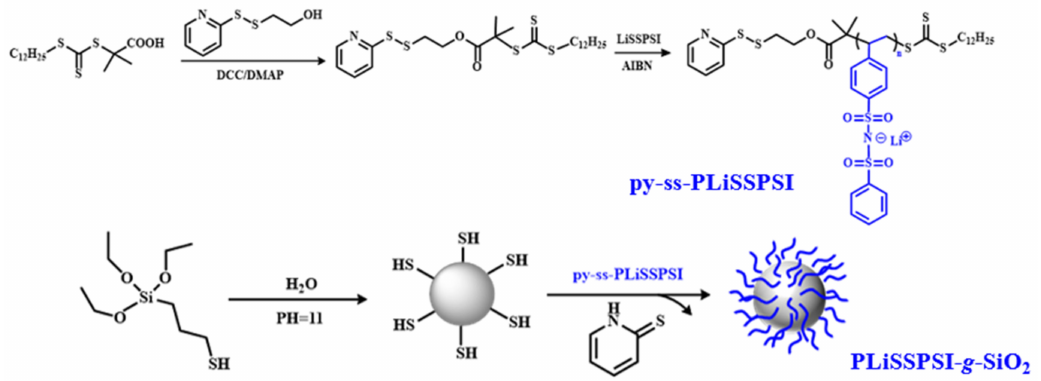
Scheme 1. Synthesis of py-ss-PLiSSPSI and PLiSSPSI- g -SiO 2 .